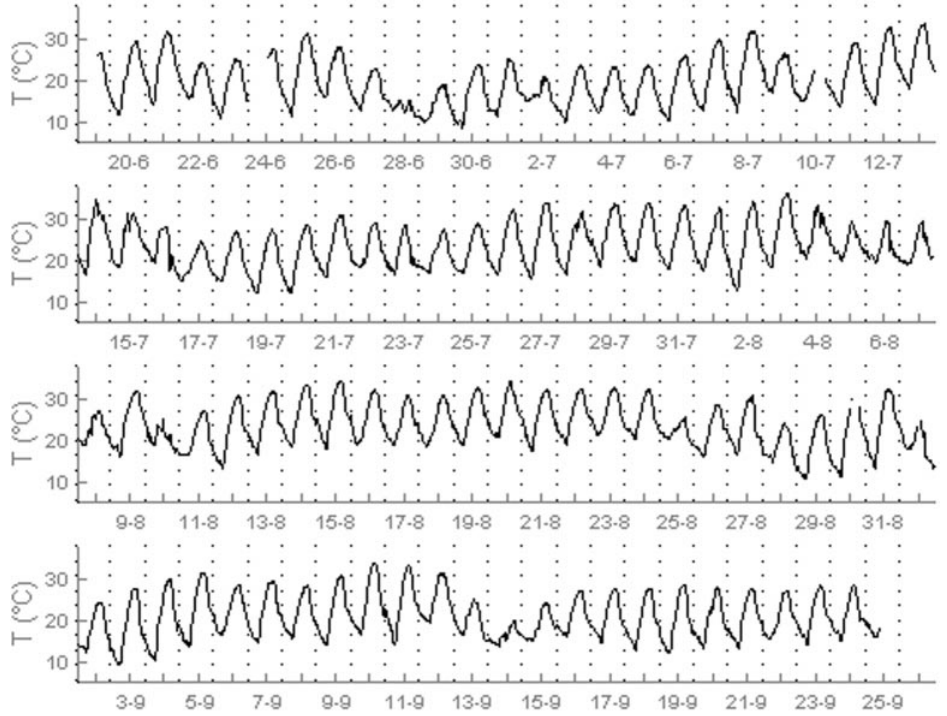
Fig. 9. Time series of air tem- perature for the 1997 WEL- SONS experiment measured at the high level on the MGS, corresponding with Tah in Fig. 1 (the exact height is given